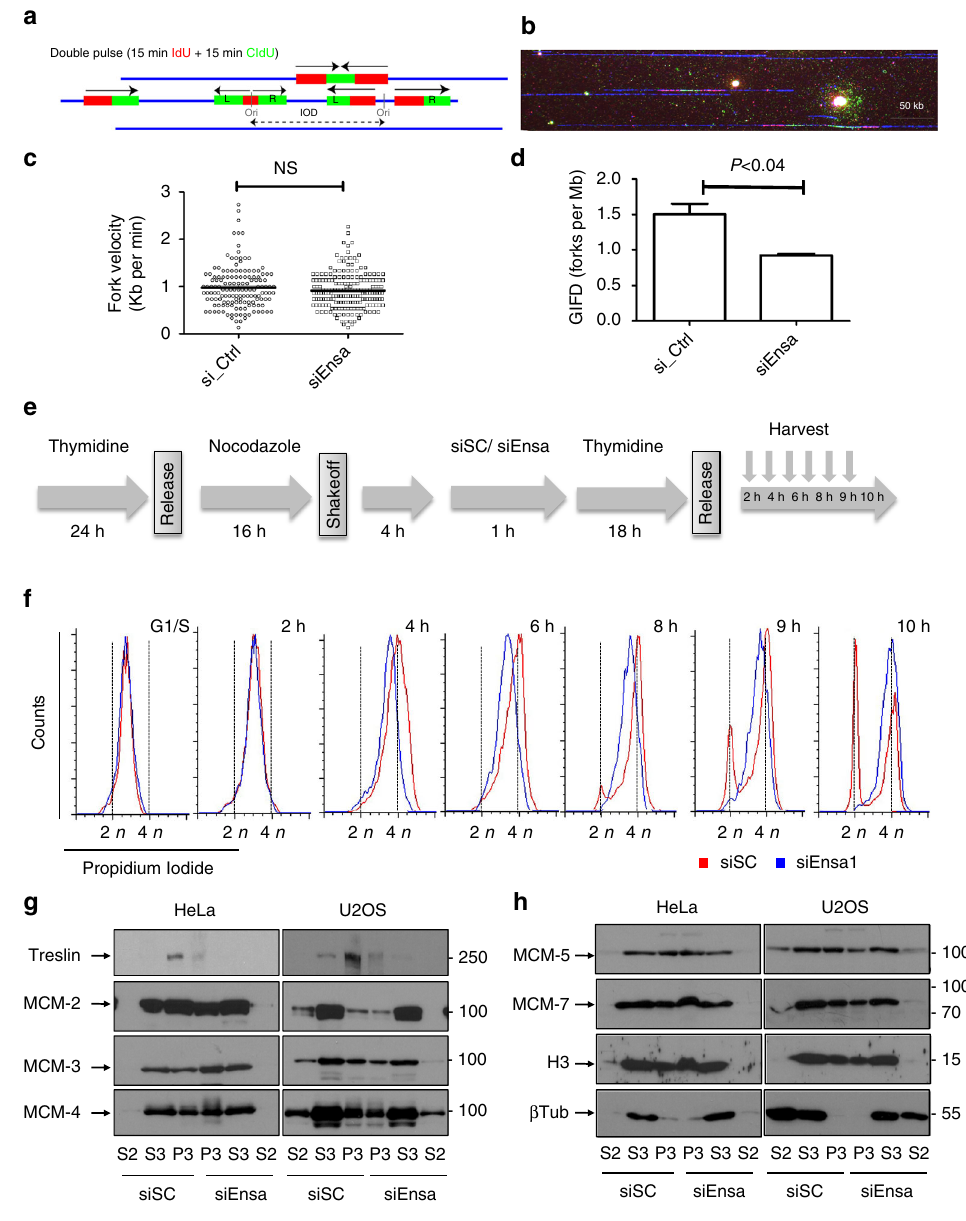
Fig. 3 Ensa KD increases S-phase length by decreasing fork number without affecting origin licensing. a Diagram depicting IdU ( red ) – CldU ( green ) double pulse analysis by DNA combing. b Representative image of a triple-stained DNA fi bre: IdU ( red ) – CldU ( green ) – DNA ( blue ). c Fork velocity (Kb/min) and d global instant fork density (GIFD) values (fork per Mb) are represented. Mean ± standard deviation and p -value obtained by using two-tailed unpaired Student ’ s t -tests, are represented. Data pooled from four biological replicates. e Diagram representing the experiment in which HeLa cells were blocked in G1 – S phase by thymidine for 24 h and subsequently released with fresh medium containing nocodazole (50 ng/ml) for a supplementary period of 16 h before shakeoff. Four hours later, released cells were transfected with siSC or siEnsa, and after 1 h, supplemented with fresh medium containing thymidine for an additional 18 h incubation. Cells were then released and recovered at the indicated times for FACS analysis. f FACS pro fi les of SC ( red ) and Ensa ( blue ) siRNA-treated cells at different time points after release are shown. g HeLa and U2OS cells were transfected with scramble (siSC) or Ensa (siEnsa) siRNAs and 48 h later processed for chromatin isolation as reported in Methods section. Cytosolic (S2) and nuclear (S3) soluble fractions as well as chromatin fraction (P3) were then used for western blot analysis to determine Treslin and MCM 2, 3 and 4 levels. h As for g , except that MCM 5 and 7, histone H3 and β -tubulin levels were checked. IOD, inter-origin distances; Ori, replication